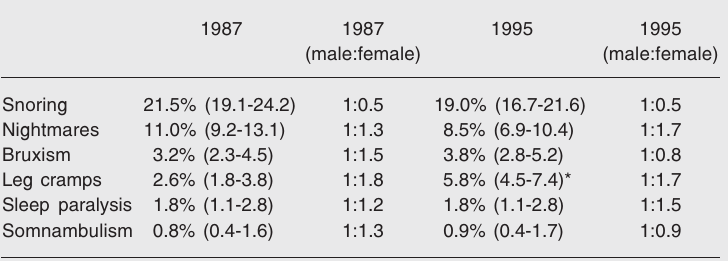
Data are reported as percent with confidence interval at 95% in parentheses. Esti- mates were based on representative samples of 1000 adults per survey. Prevalence values according to ICSD-2: snoring, 24% females, 40% males; nightmares, 2-8%; bruxism, 3-8%; leg cramps (age 60 years or over, 33%); sleep paralysis, 5-6% (any time during lifetime), 2.2% (at least monthly); somnambulism, 4% (any time during lifetime), 0.3% males, 0.1% females (monthly). *P < 0.05 compared to 1987